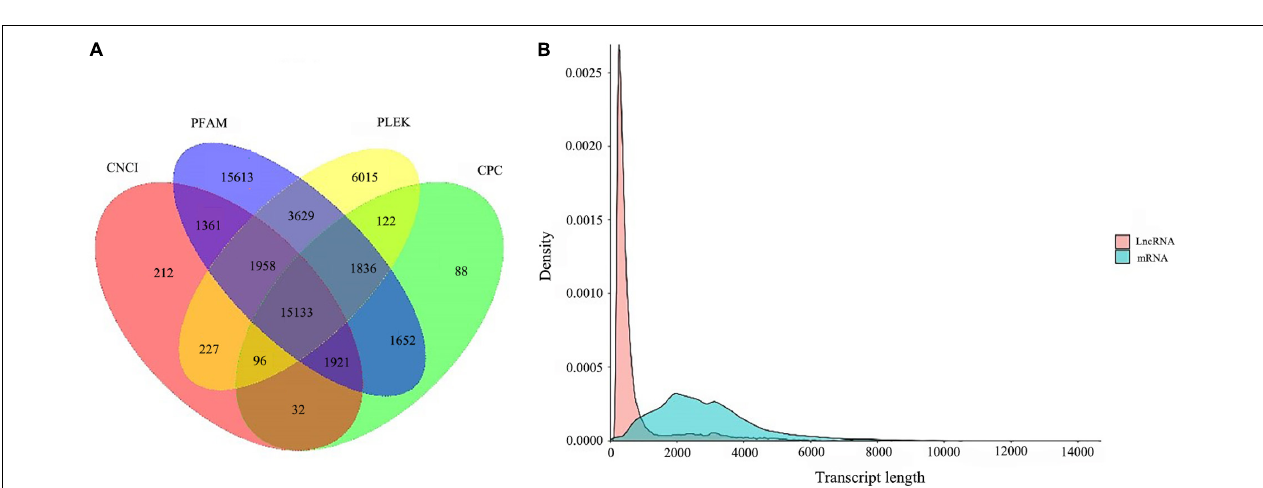
FIGURE 5 | Functional annotation and classification of B. striata . (A) Metabolism system process (KOG annotation). (B) Metabolism system pathway (KEGG annotation). (C) Metabolism system process in B. striata (GO functional classification).